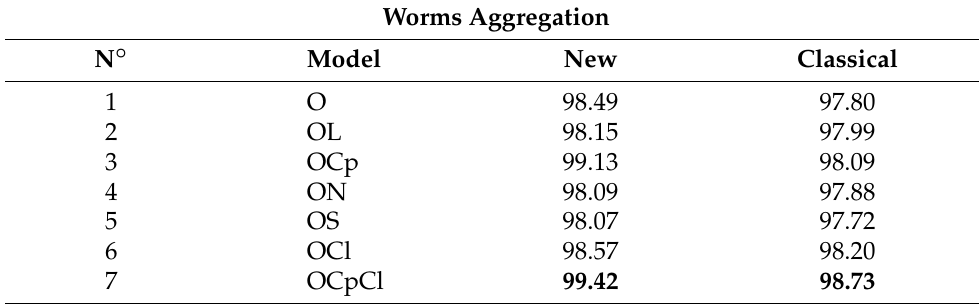
Table 3. Comparative table of percentage accuracy of postures for models and methods. The table shows the percentage accuracy of poses (skeletons) for each model and method used during the tracking of C. elegans . Overall, 3240 poses were used to evaluate tracks where there is aggregation of two or more worms, and 509 poses to evaluate the aggregation between worms and noise on the